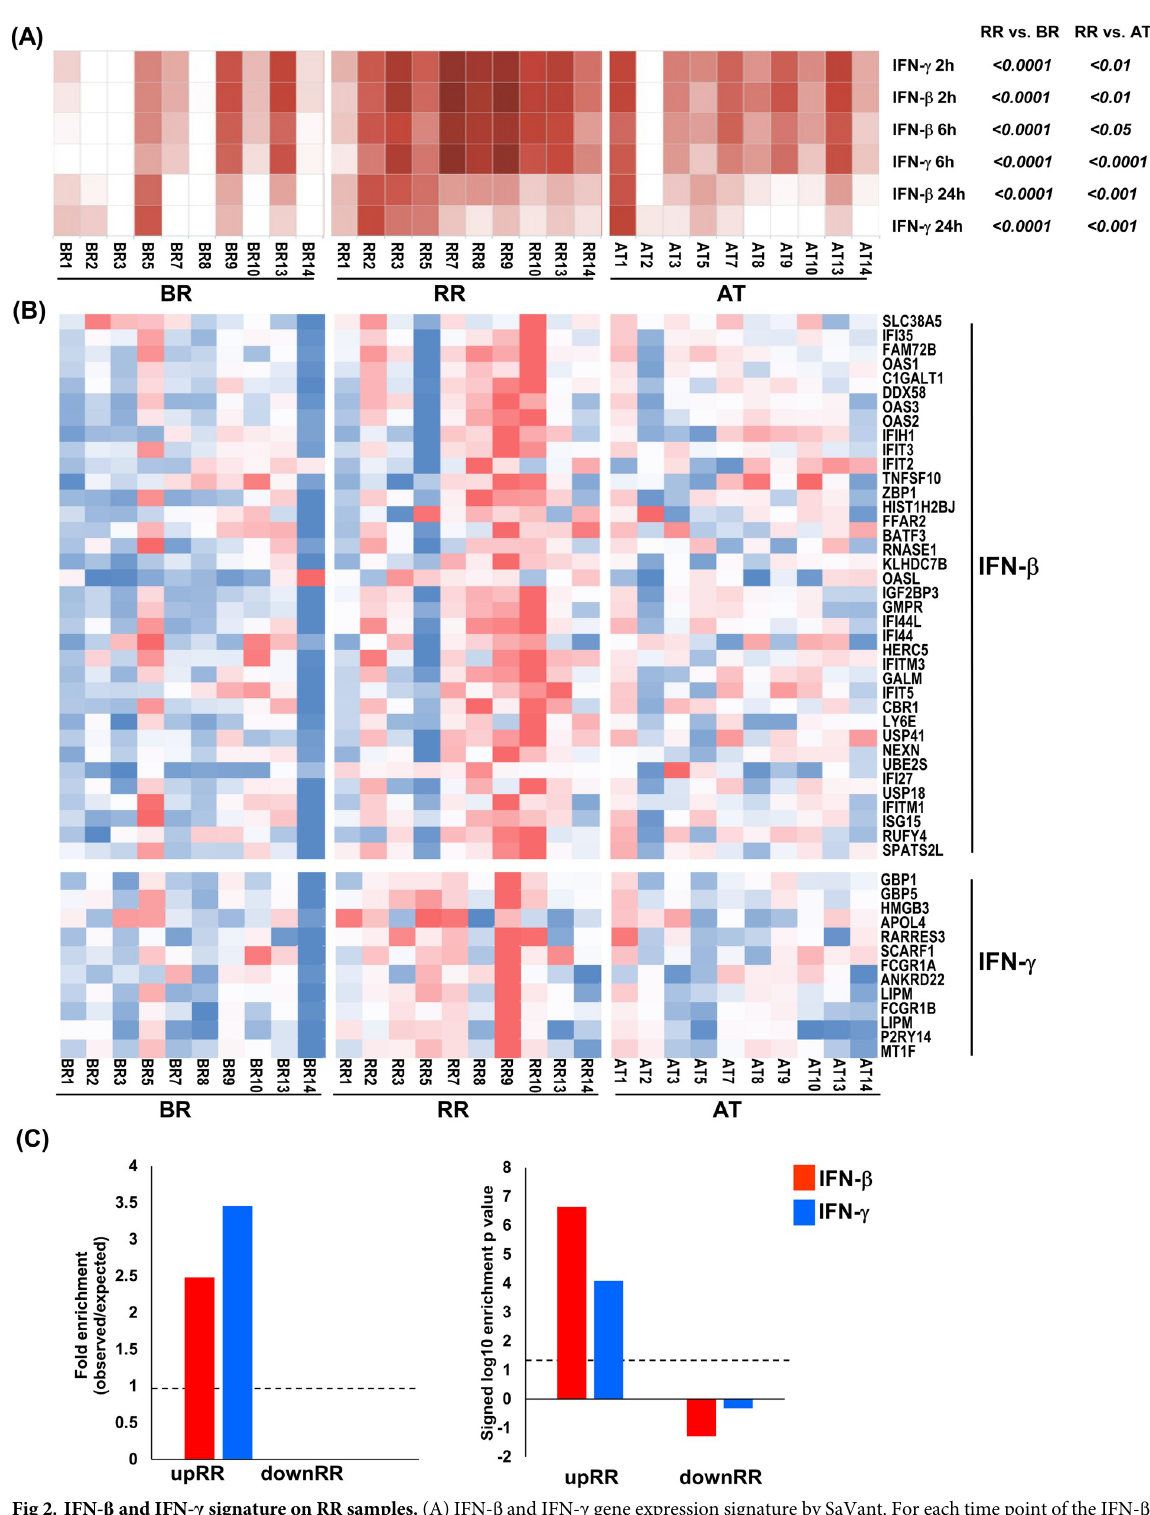
Fig 2. IFN- β and IFN- γ signature on RR samples. (A) IFN- β and IFN- γ gene expression signature by SaVant. For each time point of the IFN- β and IFN- γ MDM gene expression data, signature enrichment scores were calculated using average gene expression for each RR temporal stages and normalized to Z scores. Columns correspond to RR temporal stages and rows correspond to IFN signature; each individual square corresponds to the enrichment for one IFN signature in a specific RR sample for each subtype. P-value was calculated by one-tailed